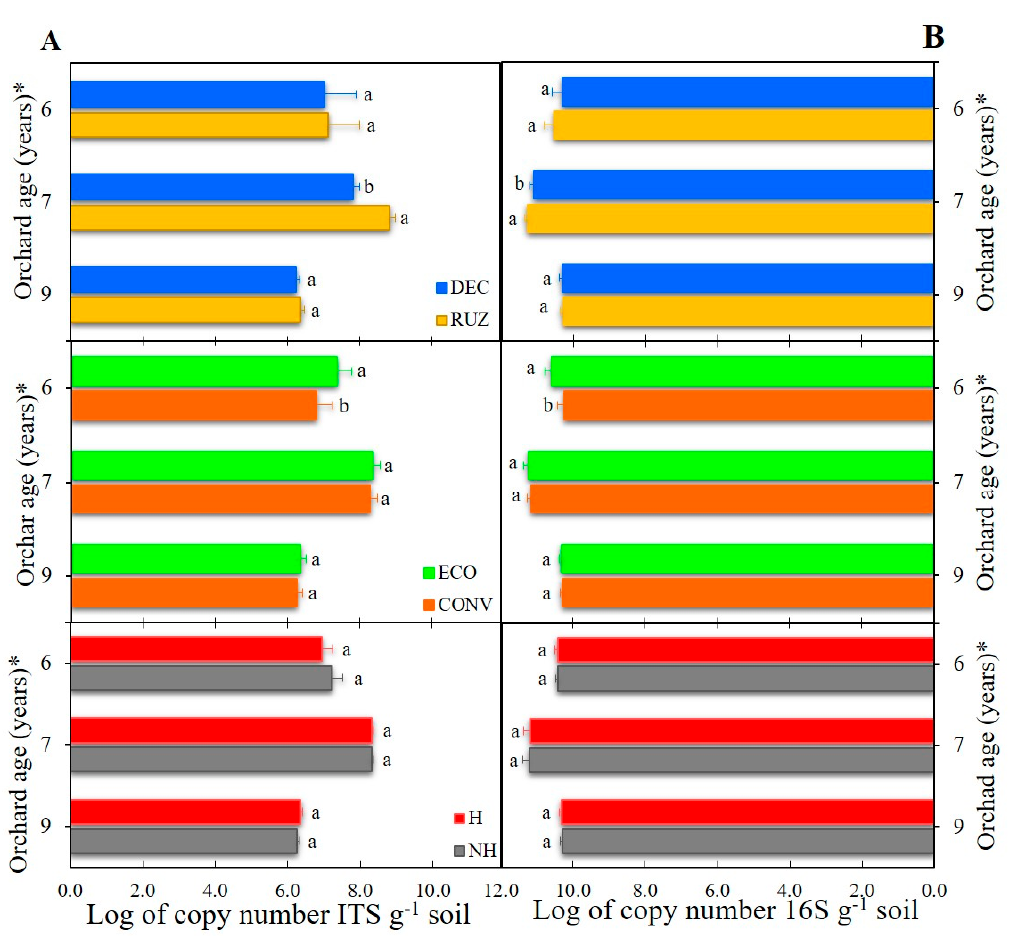
Figure 4. Abundance of the fungal gene ITS ( A ) and bacterial 16S RNA ( B ) from the rhizosphere of Tahiti acid lime plants tested with different cover crops, mowers, and the use of glyphosate (Mogi Mirim, São Paulo, 2016–2019). Legend: RUZ = Urochloa ruziziensis , DEC = U. decumbens , ECO = ecological mower, CONV = conventional mower, H = glyphosate herbicide (1080 g ae. ha − 1 ), NH = no herbicide. The significant difference was accounted for by the Tukey test ( p < 0.05), and the error bars represent the minimal significant difference. * Orchard age: growing season 2016–2017 (6), 2017–2018 (7), and 2019–2020 (9).